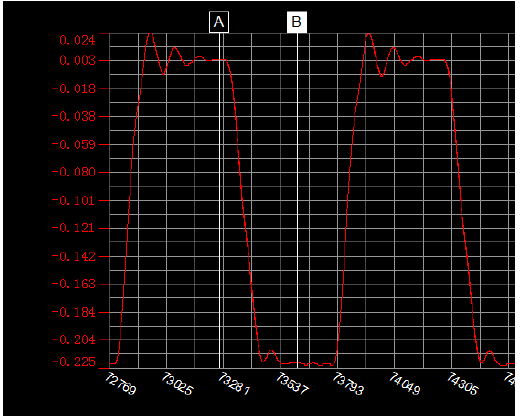
Figure 11. Motion characteristic curve of the needle.